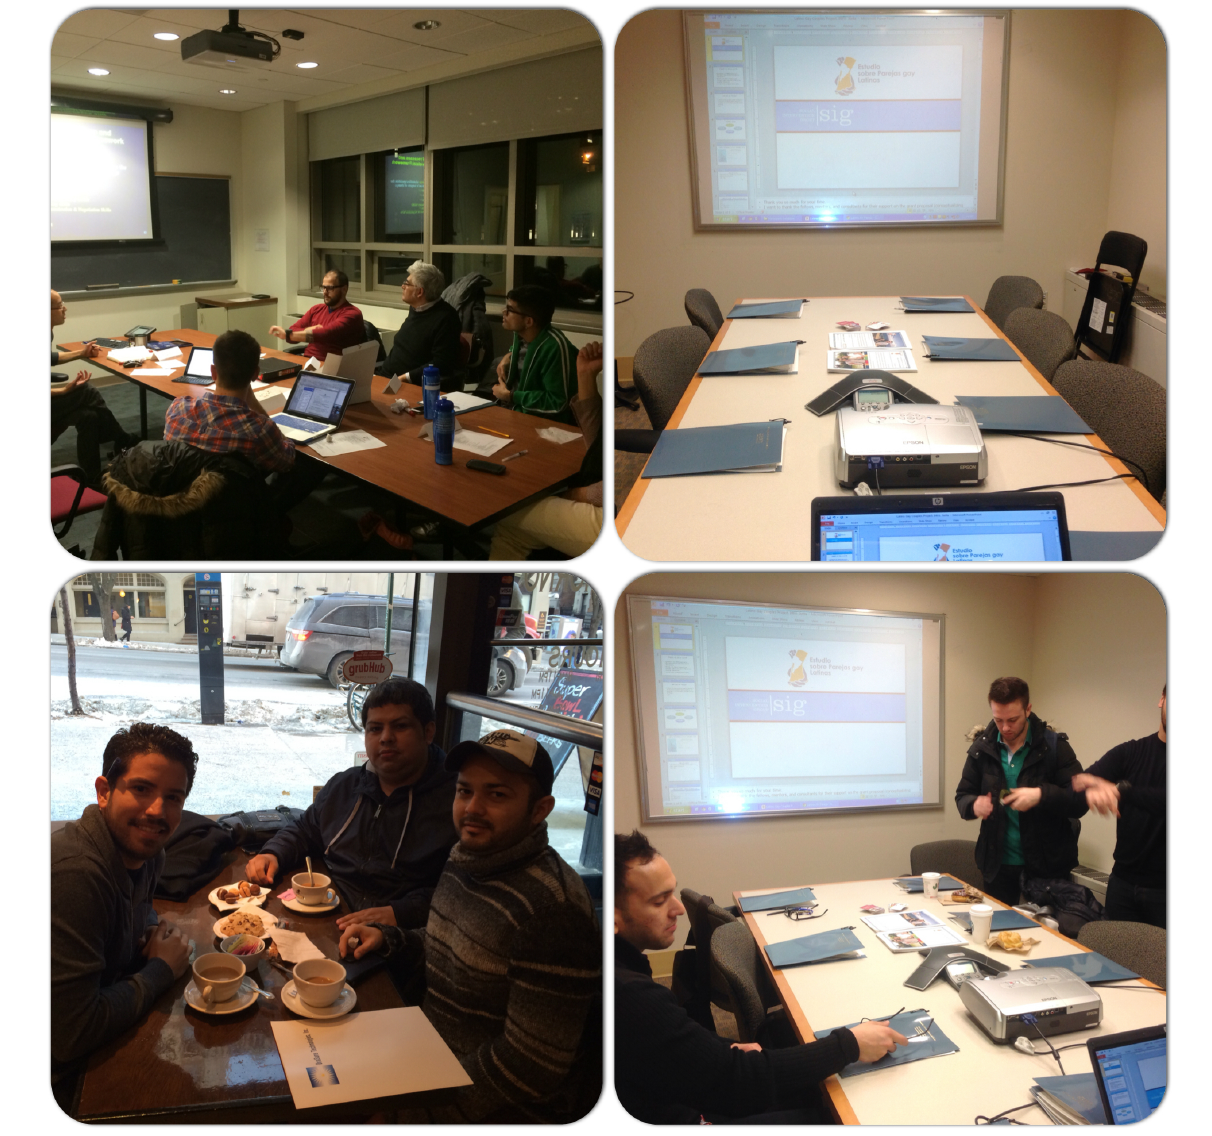
Figure 1. Collection of photos from a stakeholder